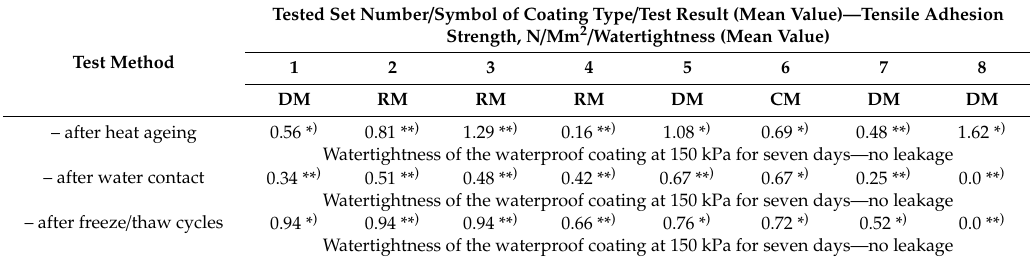
Table 3. Results of adhesive strength after ageing tests for eight coating sets.